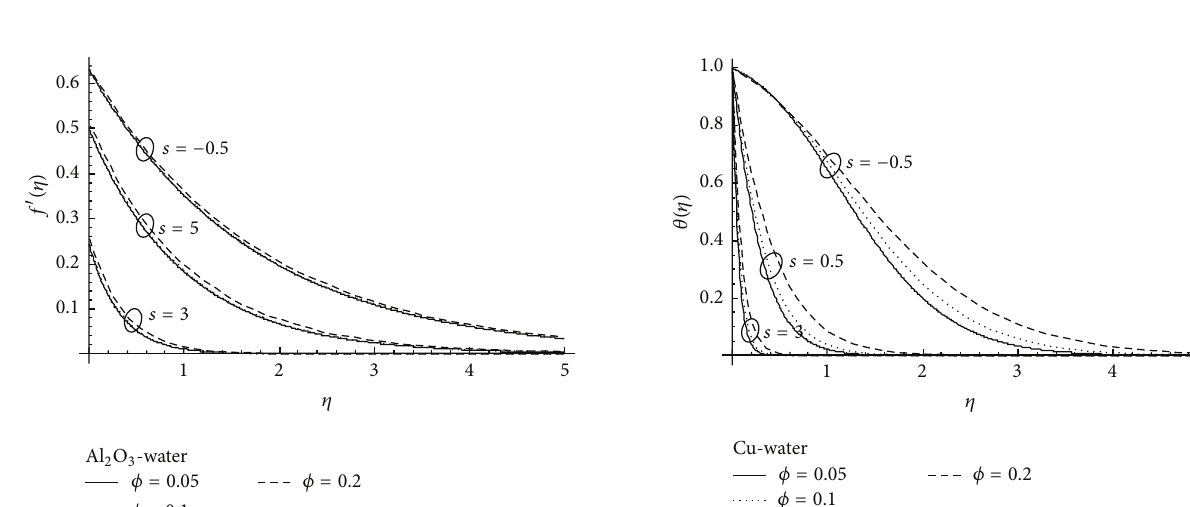
Figure 3: Comparing the variation of velocity distribution 𝑓 󸀠 (𝜂) for the investigated nanoparticles when 𝑃𝑟 = 6.2 , 𝛿 1 = 0.5 , 𝛿 2 = 0 , 𝑠 = 0.5 , and 𝜙 = 0.1 .